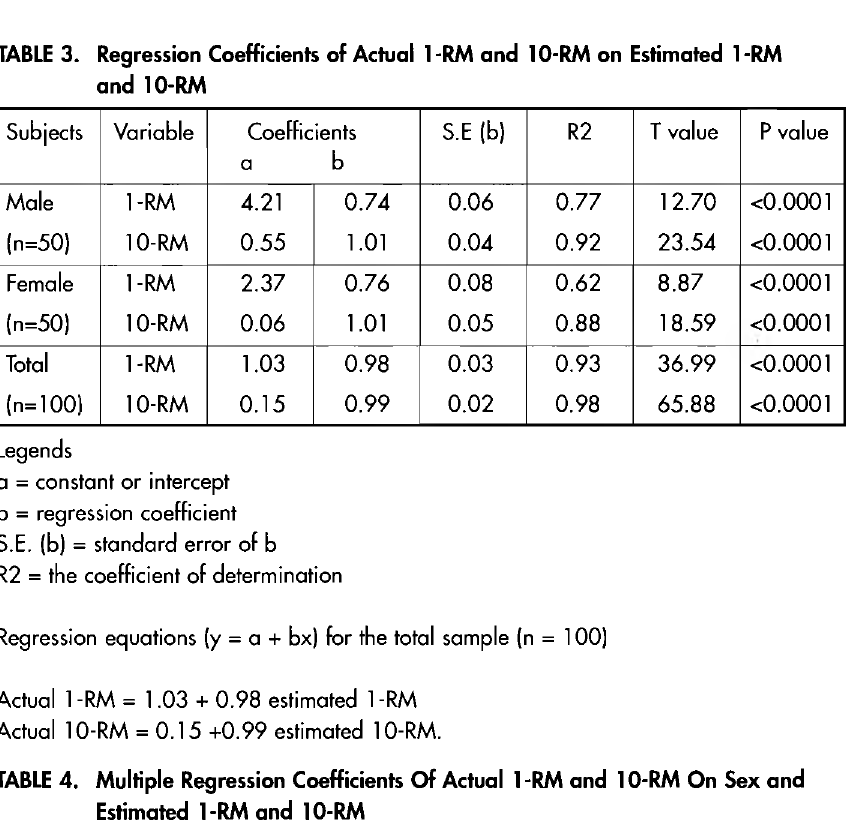
TABLE 3. Regression Coefficients of Actual 1-RM and 10-RM on Estimated 1-RM